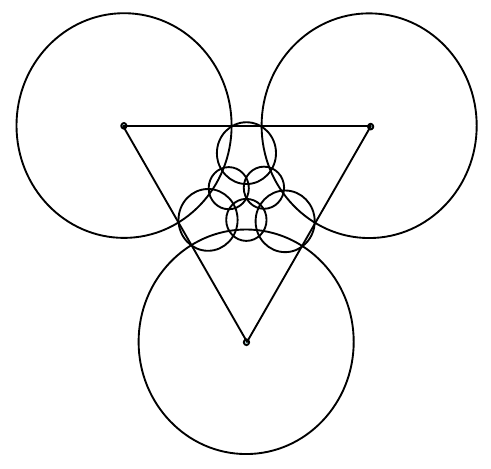
Figure 10. Coverage with three sensing